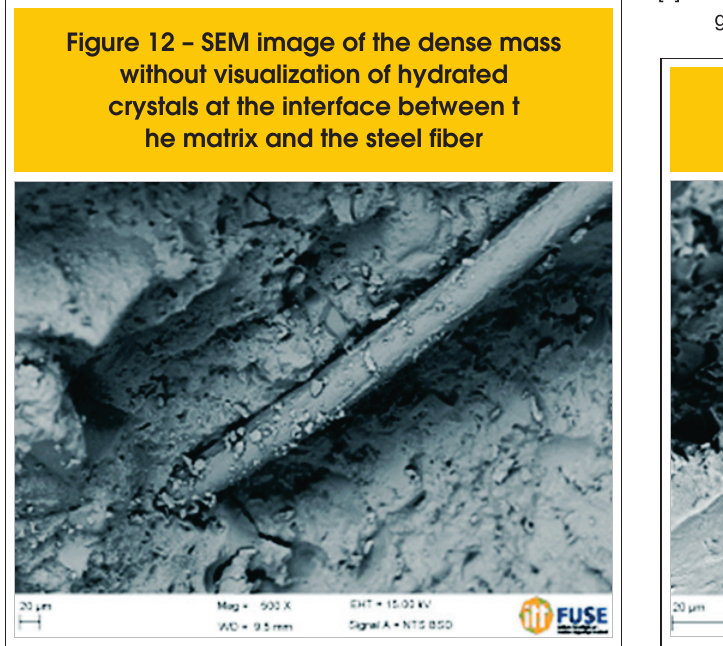
Figure 13 – SEM image of the groove where a steel fiber was